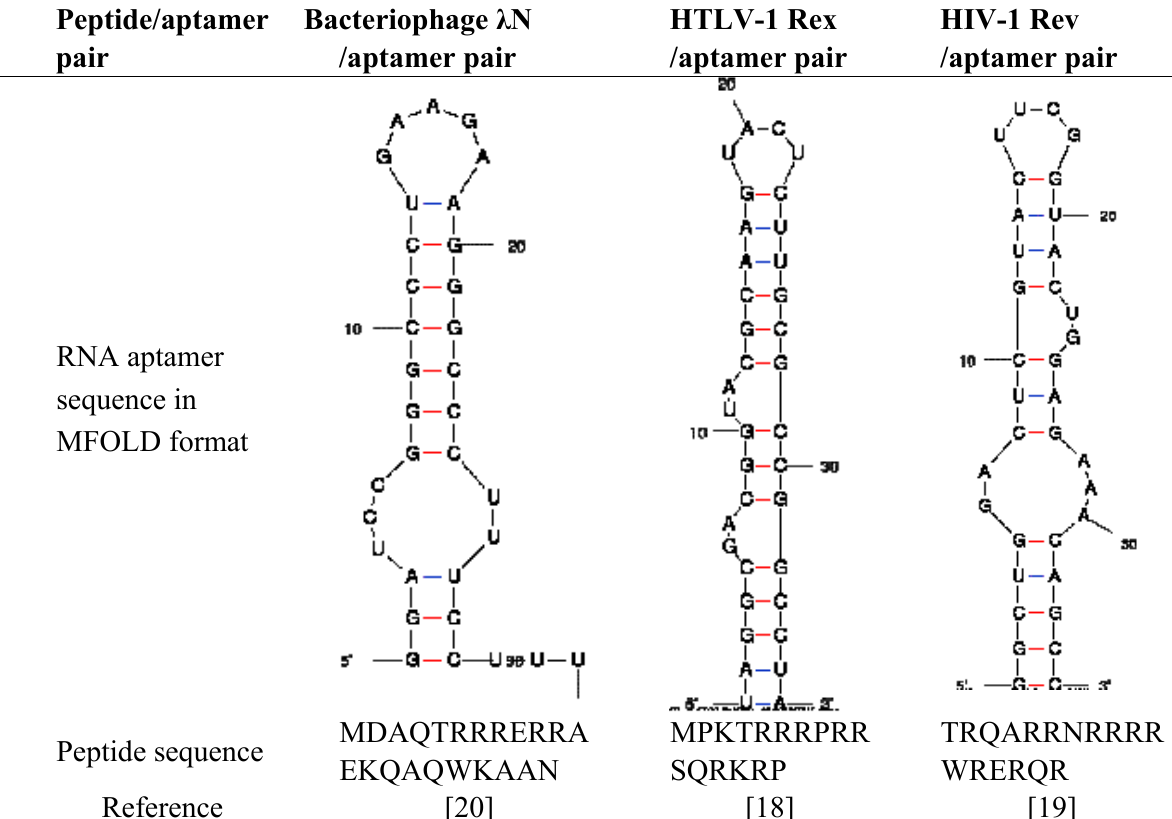
Table 1. Peptide and RNA aptamer sequences used in this